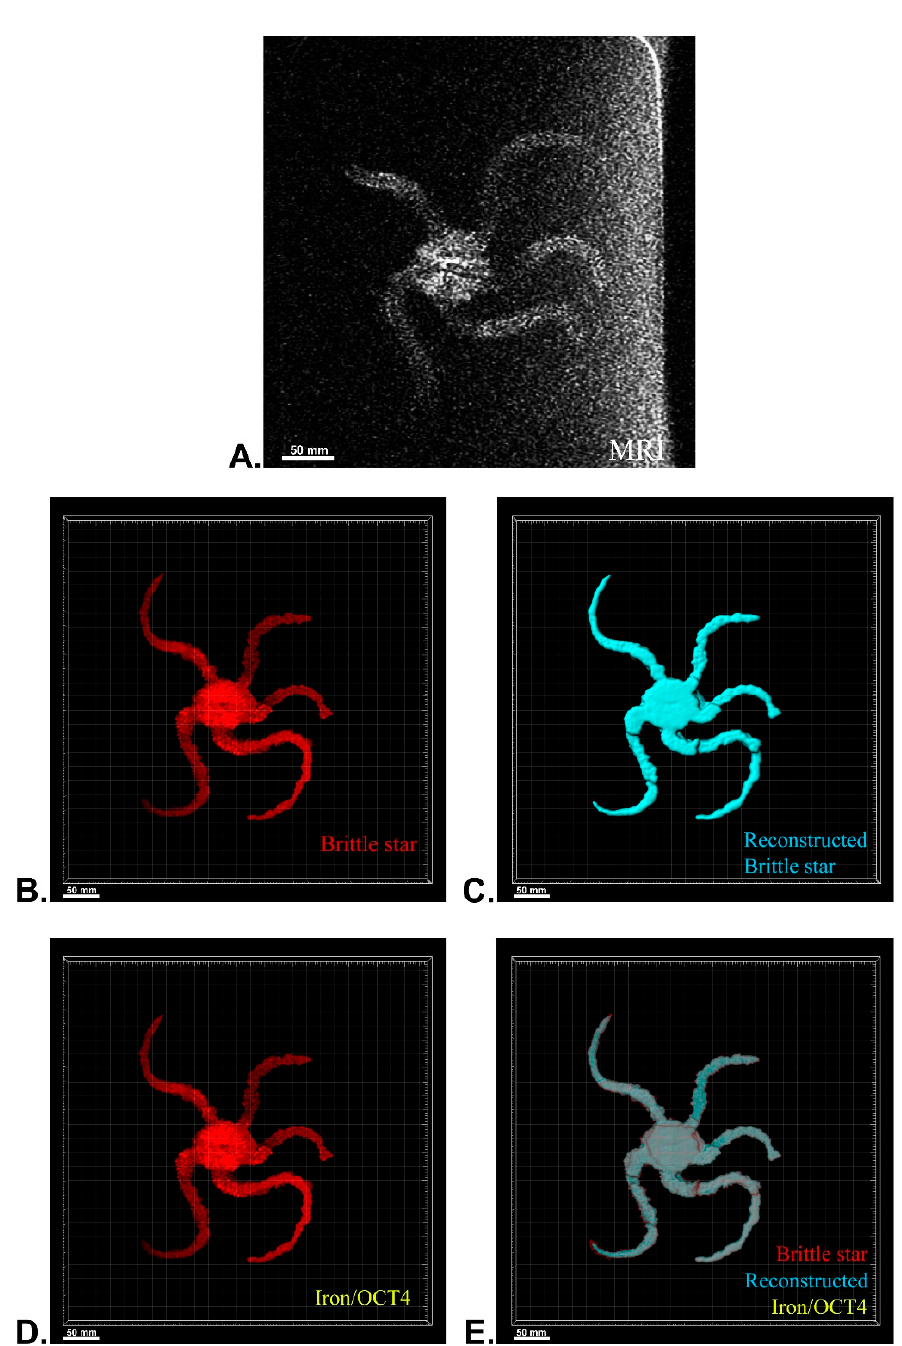
Figure 6. Three-dimensional (3D) reconstruction of brittle star tissue with no treatment using mag- netic resonance imaging (MRI) serial images: ( A ) original grayscale image; ( B ) whole tissue imaging and signals of the brittle star tissue without reconstruction; ( C ) brittle star whole tissue 3D reconstruc- tion in which the blue surface represents reconstructed brittle star tissue; ( D ) 3D reconstruction of the iron/iron plus anti-Oct4 signals, which is negative in this image; ( E ) 3D reconstruction of the whole tissue of brittle star along with all signals. All scale bars in four images are 50 mm. All images were processed and generated by Imaris software (V 7.4.2, ImarisX64; Bitplane AG, Schlieren, Swit- zerland).